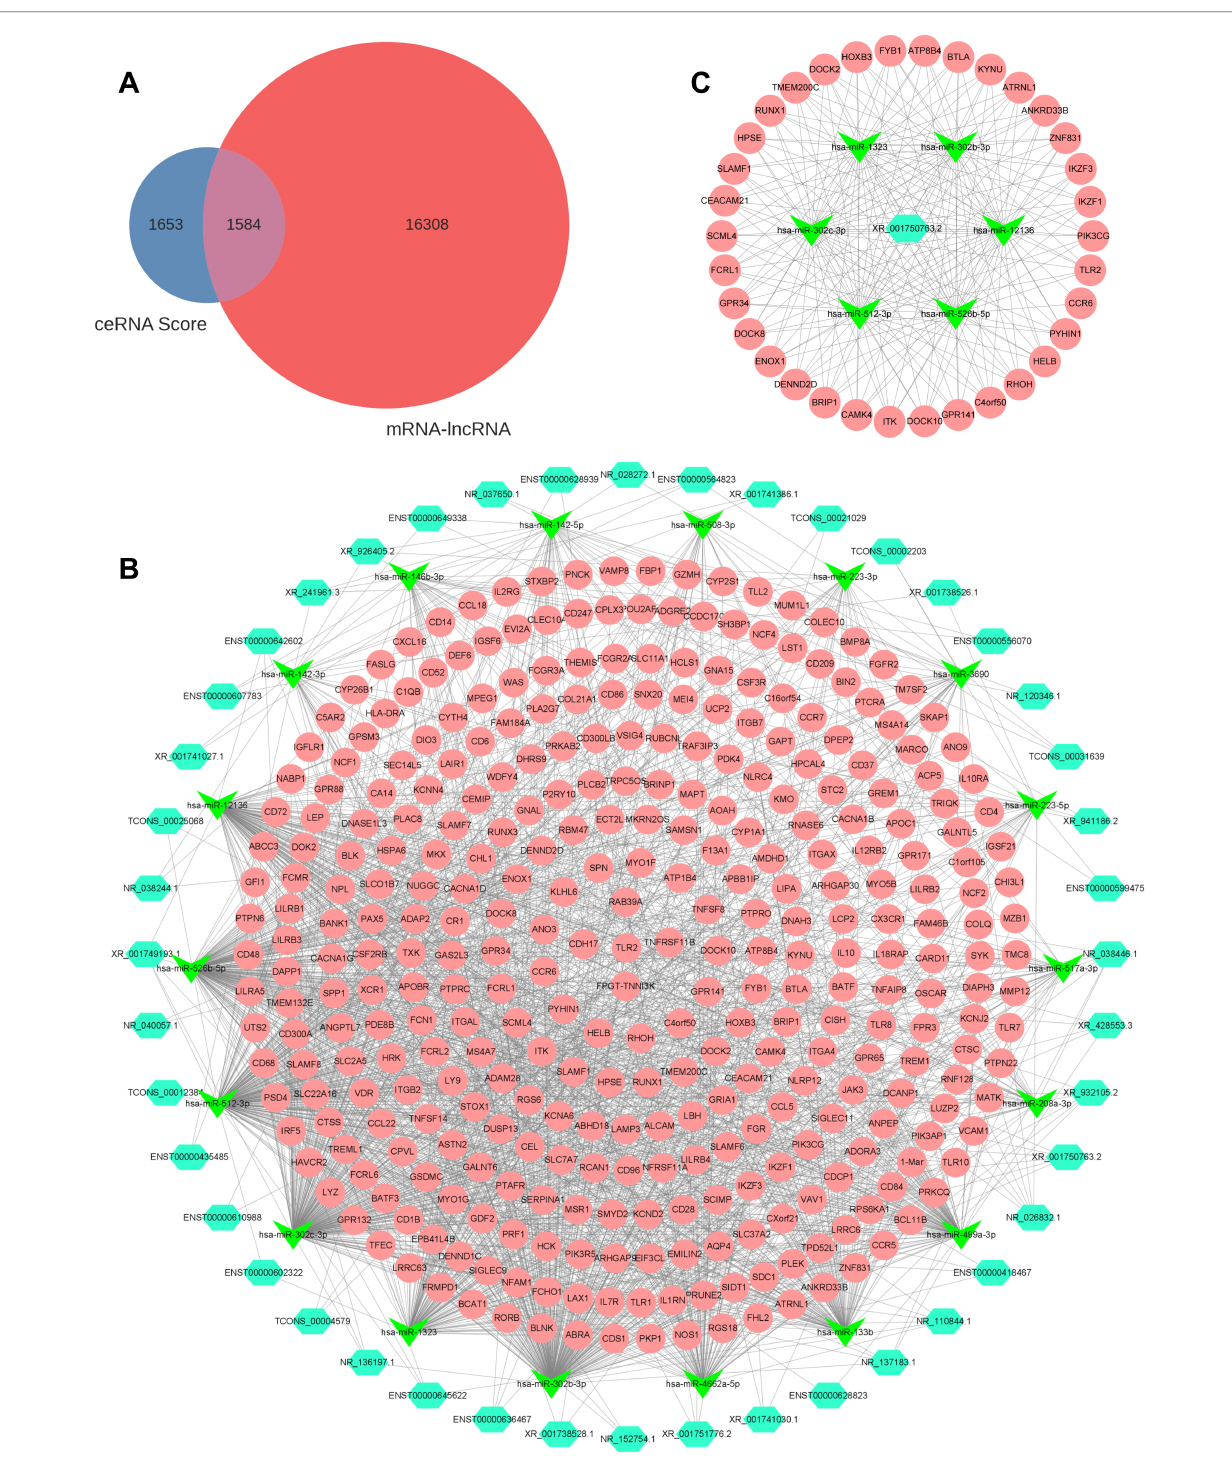
FIGURE 5 LncRNA-miRNA-mRNA regulatory network. ( A ) Venn diagram showing results of the ceRNA score and coexpression analysis. ( B ) Total lncRNA-miRNA- mRNA regulatory network. Light blue, green, and pink represent lncRNAs, miRNAs, and mRNAs, respectively. ( C ) Top 200 DElncRNA-DEmiRNA- DElncRNA axes in the ceRNA network. DE, differentially